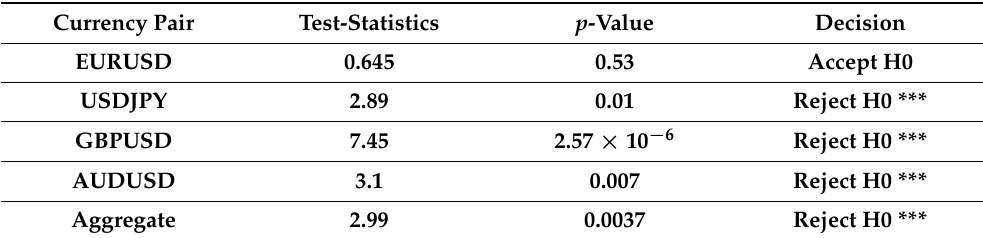
Table 6. The t -test results which corresponds to the profitability performance distribution in Figure 2c. 20 models were trained on each dataset (currency pair) where a set of 10 models was trained with the SR levels identified and a set of 10 models was not. t -Test is used to measure the statistical significance of the performance distribution differences between the 2 sets. *** refer to the 99% confidence coefficient, respectively. Results show that the performance distribution differences are significant for currency pairs USDJPY, GBPUSD,